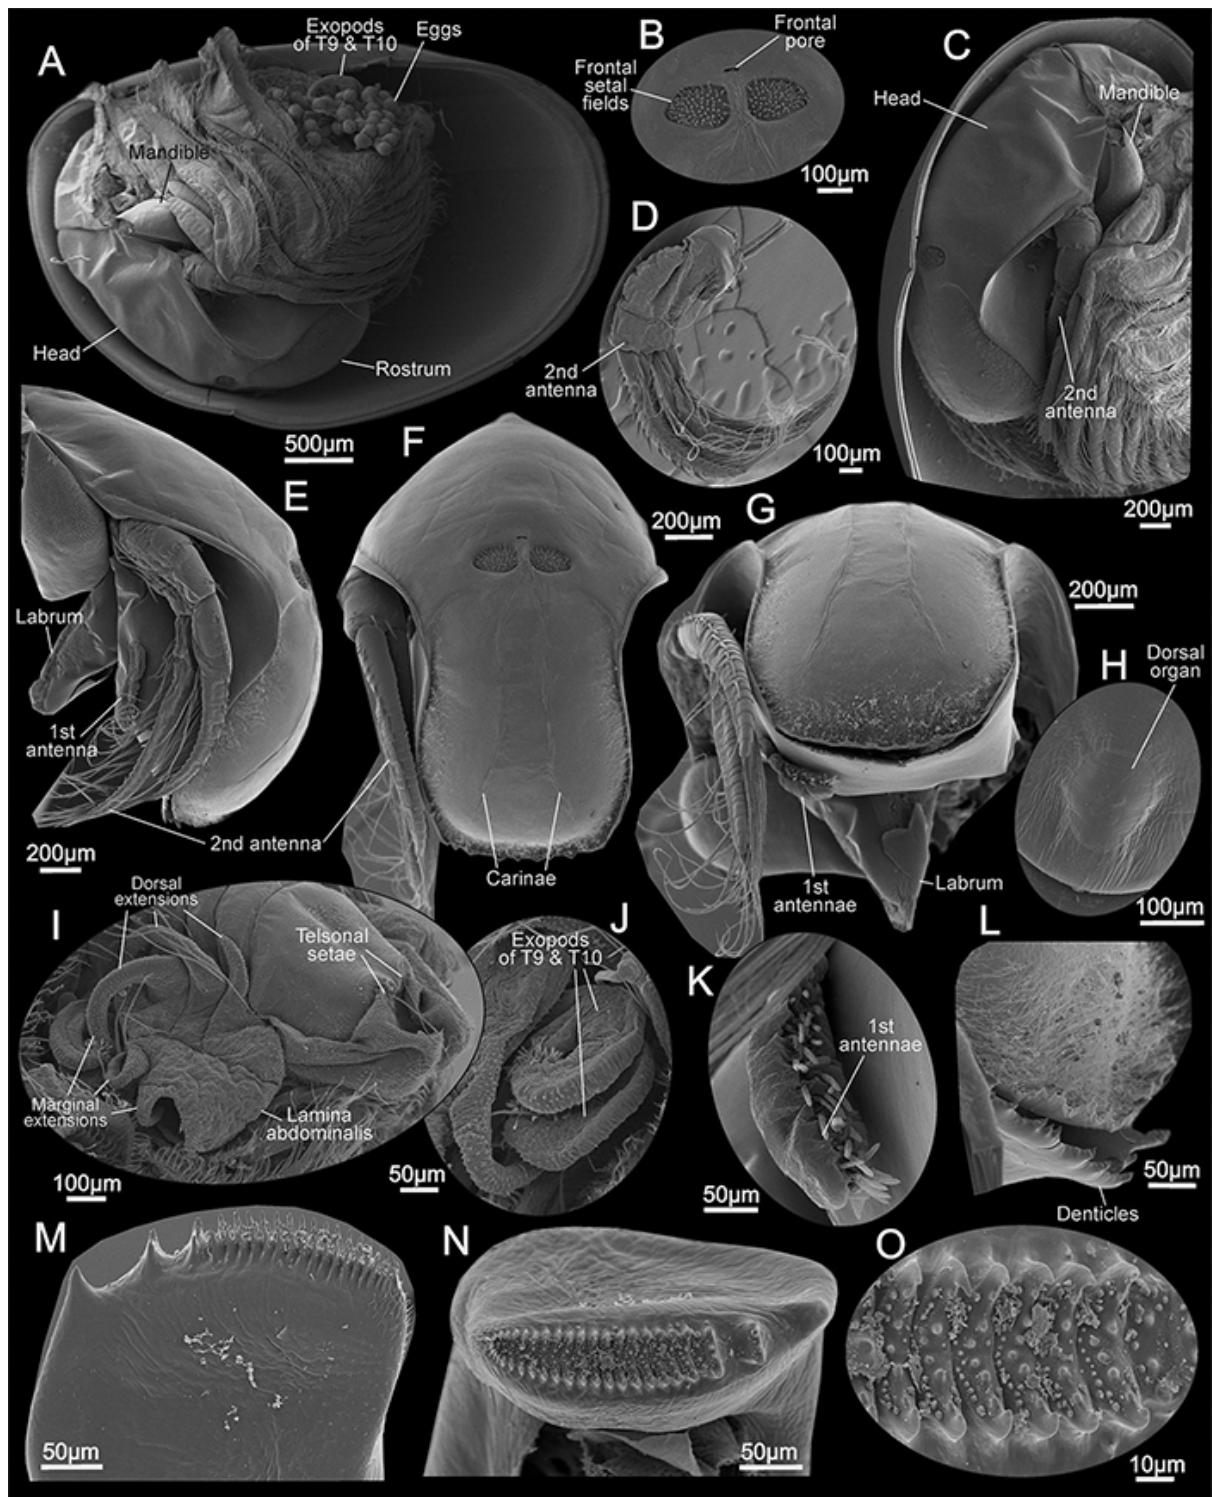
Figure 5. Lynceus grossipedia n. sp., female, scanning electron microscopy (paratype, NHMD-616086). A. Left lateral view, carapace valve removed. B. Frontal setal fields. C. Left ventrolateral view. D. Left second antenna. E. Head, lateral view. F. Head, anterior view. G. Head, anteroventral view. H. Dorsal organ. I. Telson and lamina abdominalis, dorsolateral view. J. Egg-carrying exopods of thoracopods IX and X. K. Distal part of right first antenna. L. Serration of rostral distal margin, lateral view (gap at edge likely due to drying artifact). M. Left mandible, lateral view. N. Left mandible, dorsal view. O. Mandible close-up (from